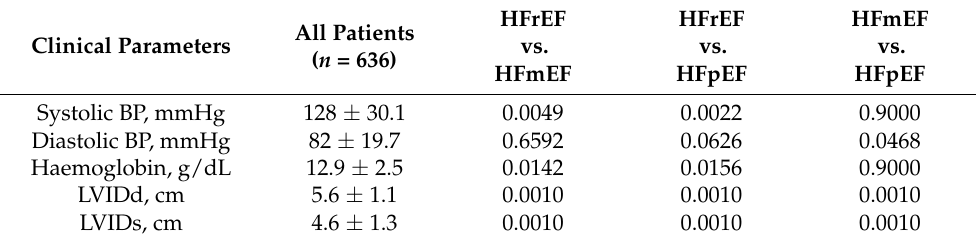
Table 4. Post hoc analysis (showing p -values) of clinical parameters in the study patients stratified according to the left ventricular ejection fraction.